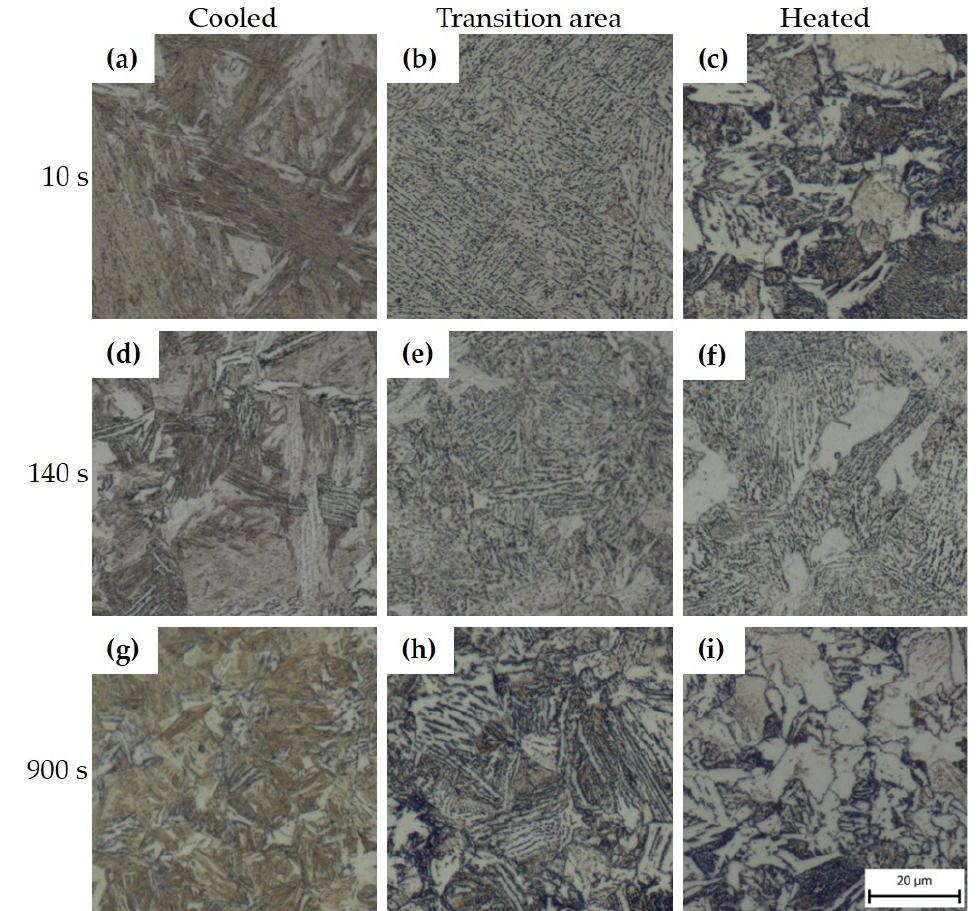
Figure 6. Microstructures of 22MnB5 after hot stamping seen under an optical microscope: ( a ) 10s_C, ( b ) 10s_T, ( c ) 10s_H, ( d ) 140s_C, ( e ) 140s_T, ( f ) 140s_H, ( g ) 900s_C, ( h ) 900s_T, ( i )